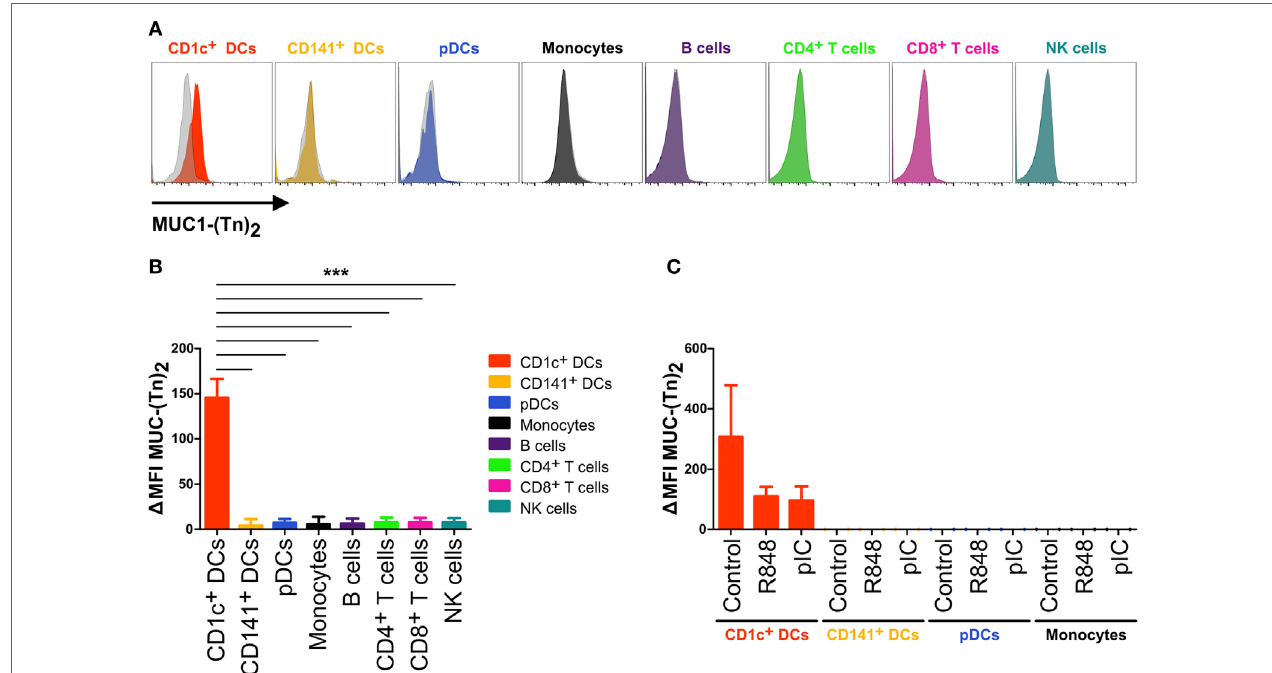
FigUre 5 | CD1c + dendritic cells (DCs) bind specifically to glycosylated ligands for CLEC10A. (a,B) PBMCs of healthy human donors were incubated with 10 µg/ml of a glycosylated or non-glycosylated MUC-1 peptide. After washing with FACS buffer twice, the cells were stained for different immune cell populations. 1.5 × 10 6 cells were acquired using a BD LSRFortessa and analyzed using FlowJo software. (a) Overlay histograms demonstrate the binding of glycosylated MUC-1-(Tn) 2 (colored) and non-glycosylated MUC-1 (gray-transparent) to CD1c + DCs (red), CD141 + DCs (yellow-orange), plasmacytoid DCs (pDCs) (blue), monocytes (black), B cells (purple), CD4 + T cells (light-green), CD8 + T cells (pink), and NK cells (cyan). (B) Bar graphs show the Δ MFI ( Δ MFI = MFI MUC-1-(Tn) 2 − MFI MUC-1) for the binding of Tn antigen to CLEC10A for the same cell populations as in (a) . Significant differences in the binding of MUC-1-(Tn) 2 to cell populations were calculated using one-way ANOVA with Bonferroni posttest (* p < 0.05, ** p < 0.01, and *** p < 0.001). (c) CD1c + DCs (red), CD141 + DCs (yellow-orange), pDCs (blue), and monocytes (black) of PBMCs of healthy donors were sorted using a FACS Aria II and subsequently incubated with 10 µg/ml FITC-coupled MUC-1-(Tn) 2 or MUC-1 and stimulated with either 5 µg/ml R848, 5 µg/ml pIC, or left untreated. After 12 h at 37°C, the cells were analyzed for the binding of MUC-1-(Tn) 2 by flow cytometry. Bar graphs show the Δ MFI of MUC-1-(Tn) 2